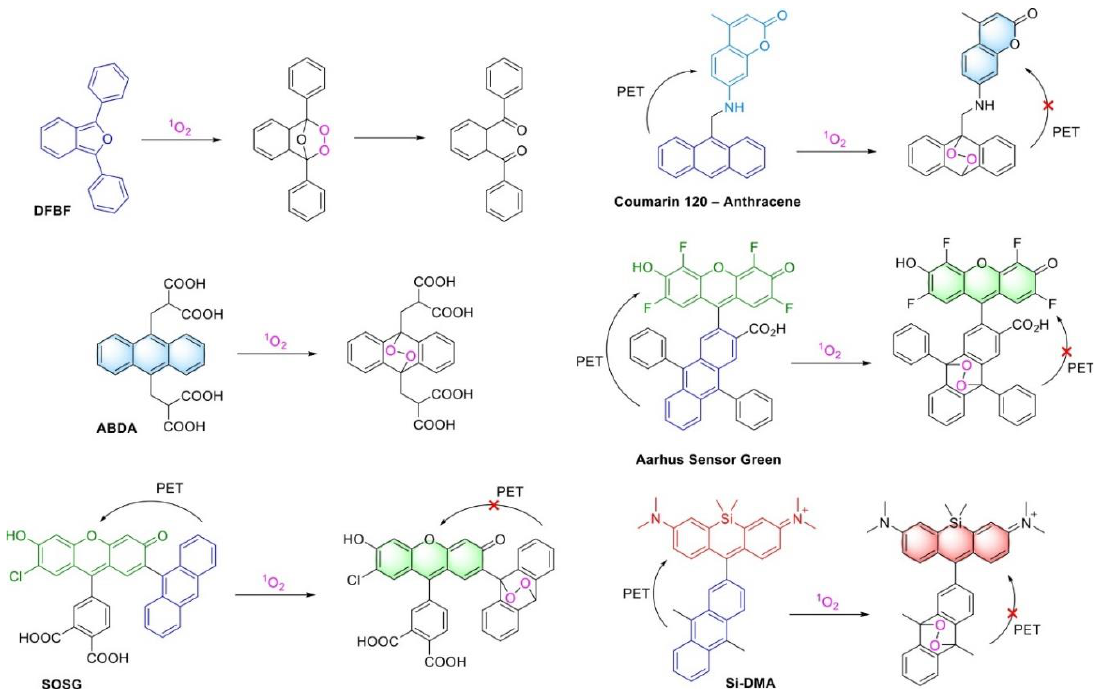
Figure 1. Examples of colorimetric and fluorescent singlet oxygen sensors, as well as reactions leading to changes in its optical properties.